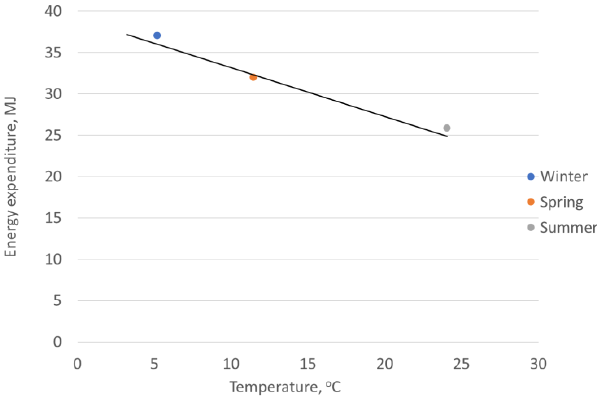
Fig. 3. Energy expenditure for a distance of 50 km in relation to the aver- age temperature over a given season Paying attention to values of energy expenditure, it can be stated that it depends on temperature, while the total cumulative energy expenditure of tested car over a distance of 12 500 km in a given quarter increases in a linear manner and is characterized by a high coefficient of determination R 2 (Fig.